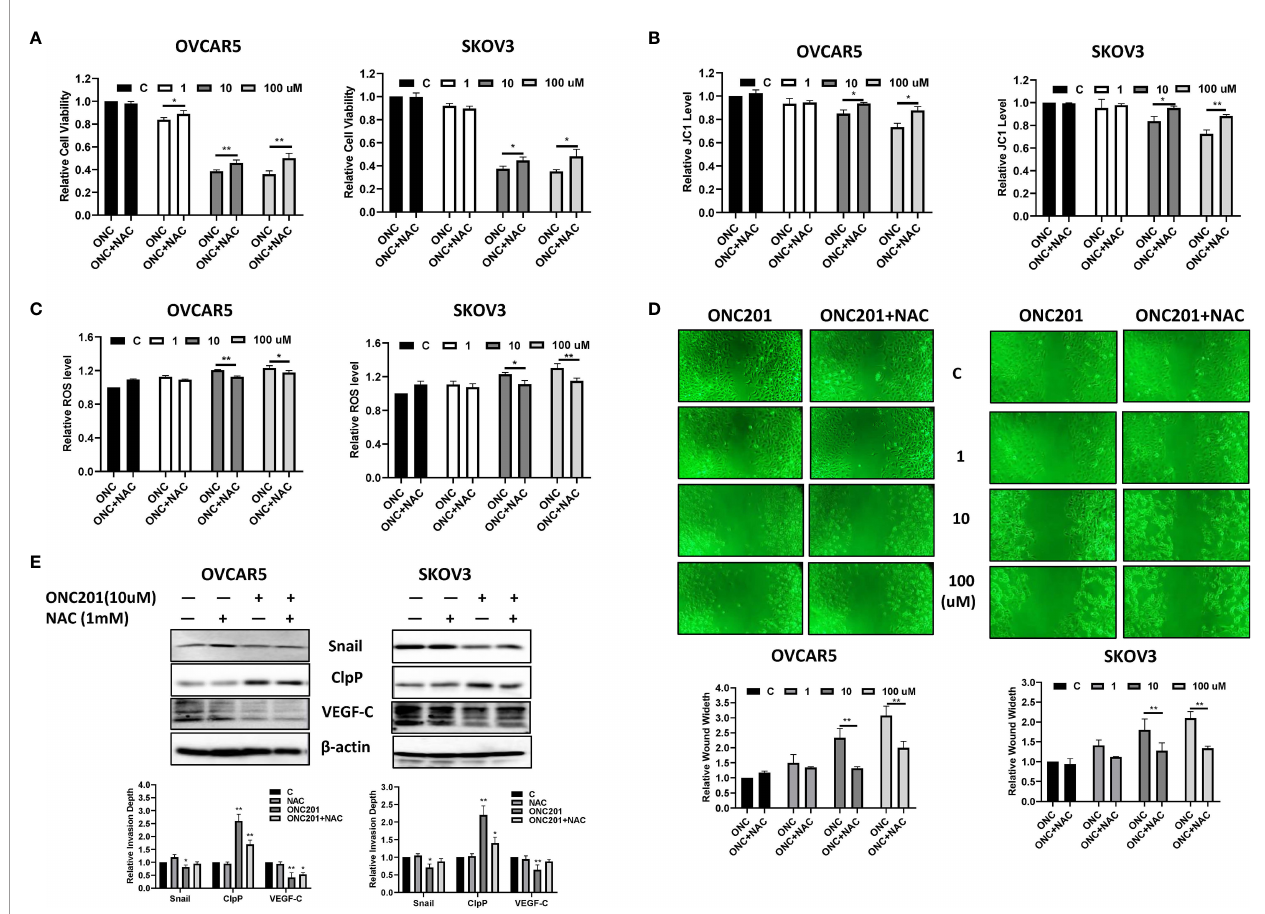
FIGURE 7 | ONC201 inhibited adhesion and invasion through cellular stress pathways in OC cells. Pre-treatment of the OVCAR5 and SKOV3 cells with 1 mM NAC partially blocked inhibition of ONC201-mediated proliferation in both cell lines (A) . Similarly, pre-treatment with NCA for 6 hours in OVCAR5 and SKOV3 cells signi fi cantly reduced ROS levels and recovered mitochondrial membrane potential induced by ONC201 compared to the vehicle controls (B, C) . The cells were pre-treated with NAC for 6 hours, followed by treatment with ONC201 for 48 hr. Wound healing was observed by a microscope with phase contrast. ONC201 decreased cell migration, and NAC effectively reversed ONC201-inhibited cell migration in the OVCAR5 and SKOV3 cells. All images were obtained from three independent experiments (D) . The effect of NAC and ONC201 on the expression of ClpP, VEGF and Snail was examined by Western blotting in OVCAR5 and SKOV3 cell lines after 30 hours of treatment (E) . *P < 0.05, **P <